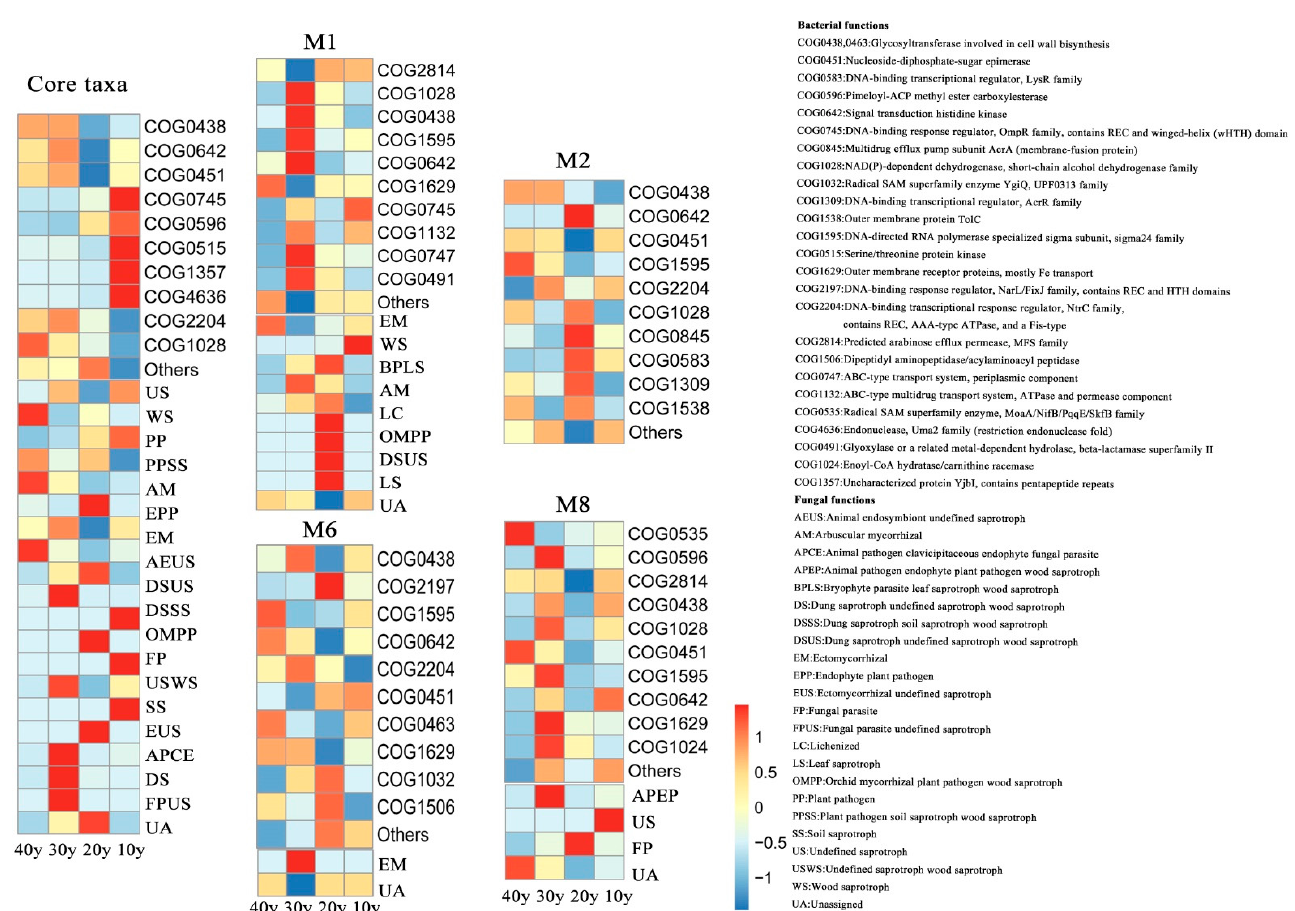
Figure 6. Bacterial and fungal functional predictions for the core microbiota as annotated by PICRUSt 2 and FUNGuild. (Core taxa, M1, M2, M6 and M8).